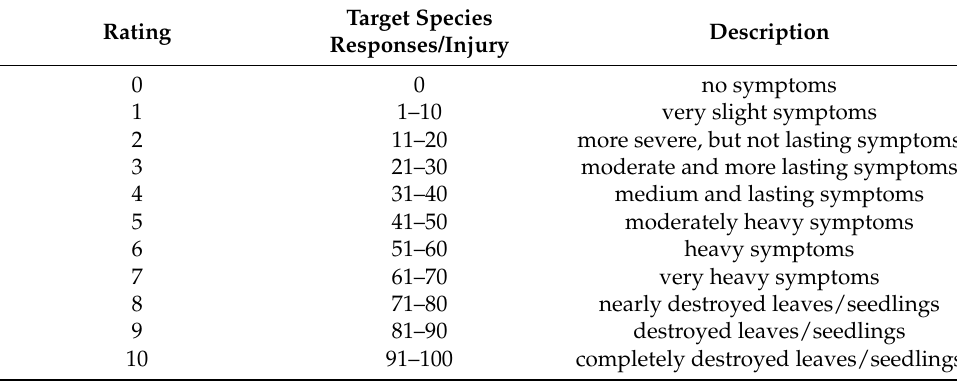
Table 6. Visual phytotoxicity rating